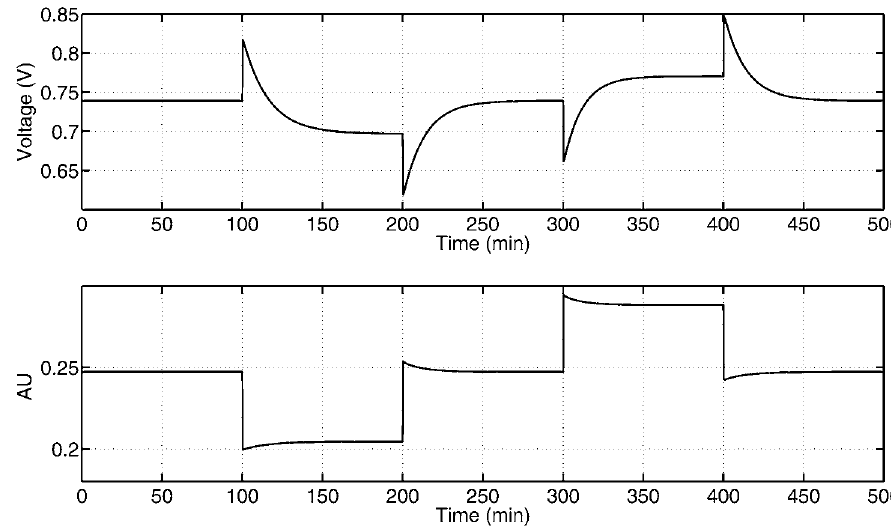
Figure 4. Voltage and AU profiles during fuel flow